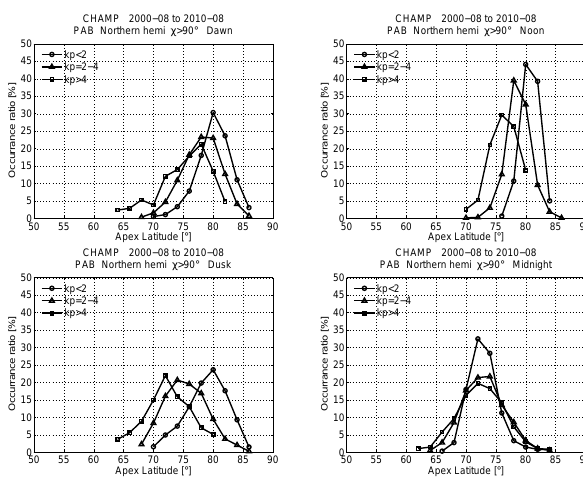
Figure 5. Activity dependence of the equatorward auroral boundary Fig.5. ActivitydependenceoftheequatorwardauroralboundarylatitudedistributionfordifferentMLTsectors: latitude distribution for different MLT sectors: dawn (top left), noon dawn (top left), noon (top right), dusk (bottom left), midnight (bottom right). (top right), dusk (bottom left), and midnight (bottom right).